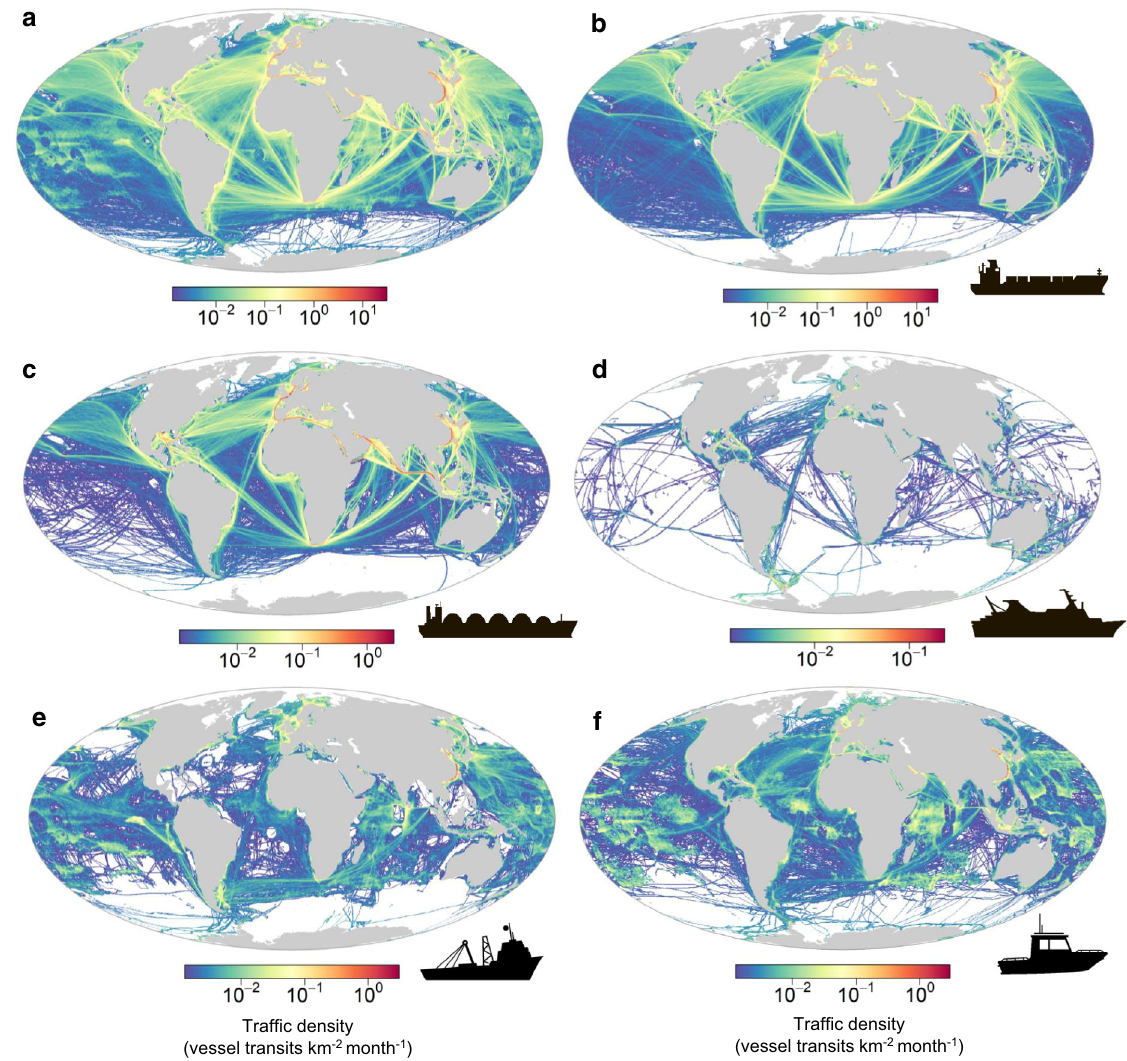
Fig. 2 Global density of marine traf fi c. Density maps showing the average number of vessel transits per square kilometre per month during the fi rst half of 2020 (January – June). Vessel categories: a all vessels, b cargo, c tanker, d passenger, e fi shing and f other vessels. Density estimates plotted on a logarithmic (log 10) colour